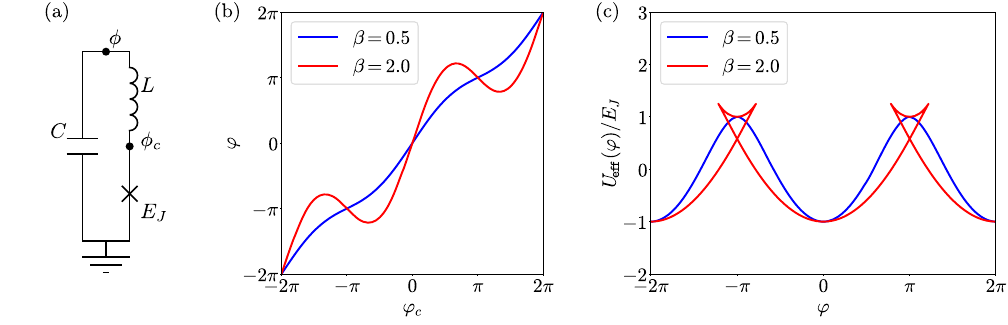
FIG. 3. Series combination of a linear inductance L and a Josephson junction E with a shunting capacitance C . (a) Circuit model. J (b) Constraint relating the rescaled flux variables φ and φ [see Eq. (13)] for the different cases β ≤ 1 (blue) and β > 1 (red), in which the c φ Þ is either a well-defined function of φ or multivalued, respectively. (c) Effective one-dimensional potential constrained variable φ c ð φ Þ is [cf. Eq. (11)] obtained by substituting the constrained variable for the different cases β ≤ 1 (blue) and β > 1 (red), in which U eff ð either a well-defined function of φ or multivalued,